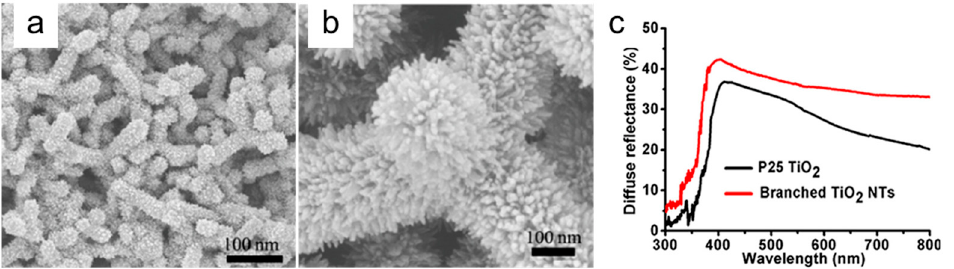
Figure 8. SEM images of hierarchical titania nanostructures ( a , b ), and diffuse reflectance spectra ( c ) of electrodes made of commercial titania nanoparticles (black curve) and of hierarchical nanostructures (red curve). Adapted with permission from [142]. Copyright 2014, American Chemical Society.